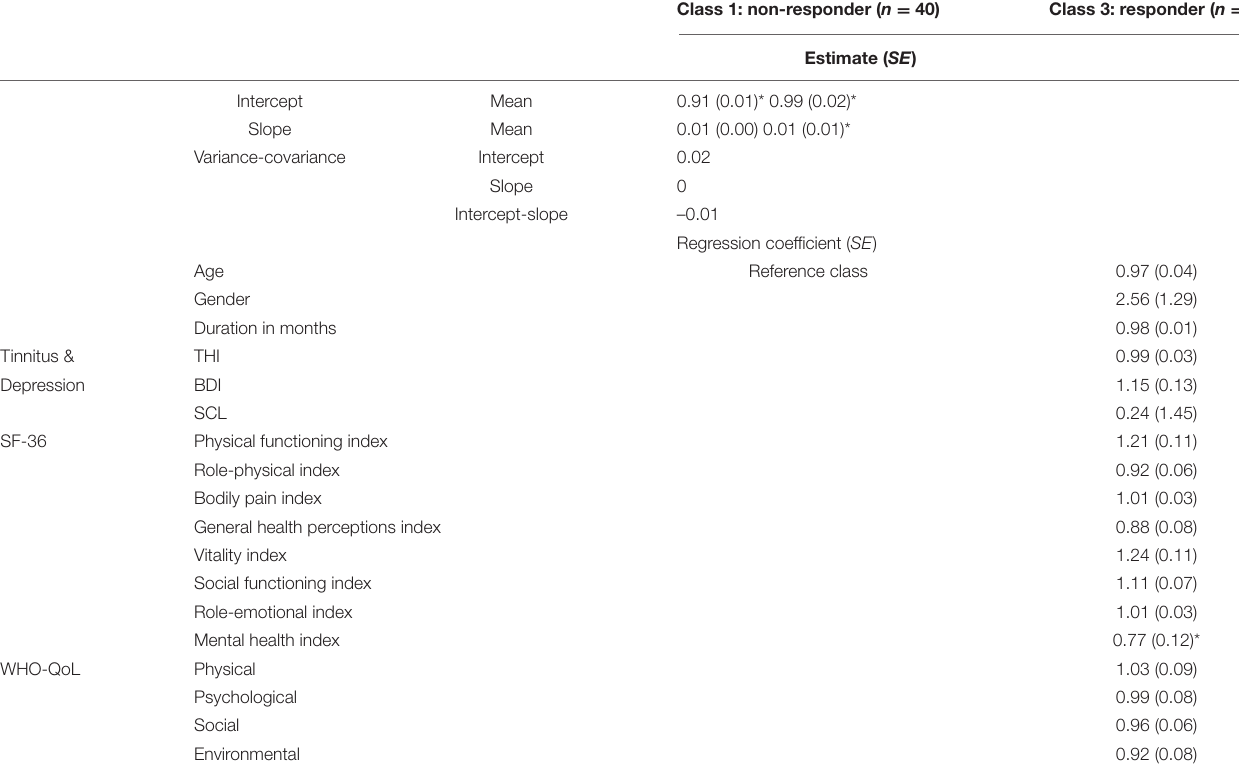
TABLE 3 | Firth’s binary logistic regression with dichotomized dependent variables (0 = non-responder; 1 = responder) of class membership ( n =